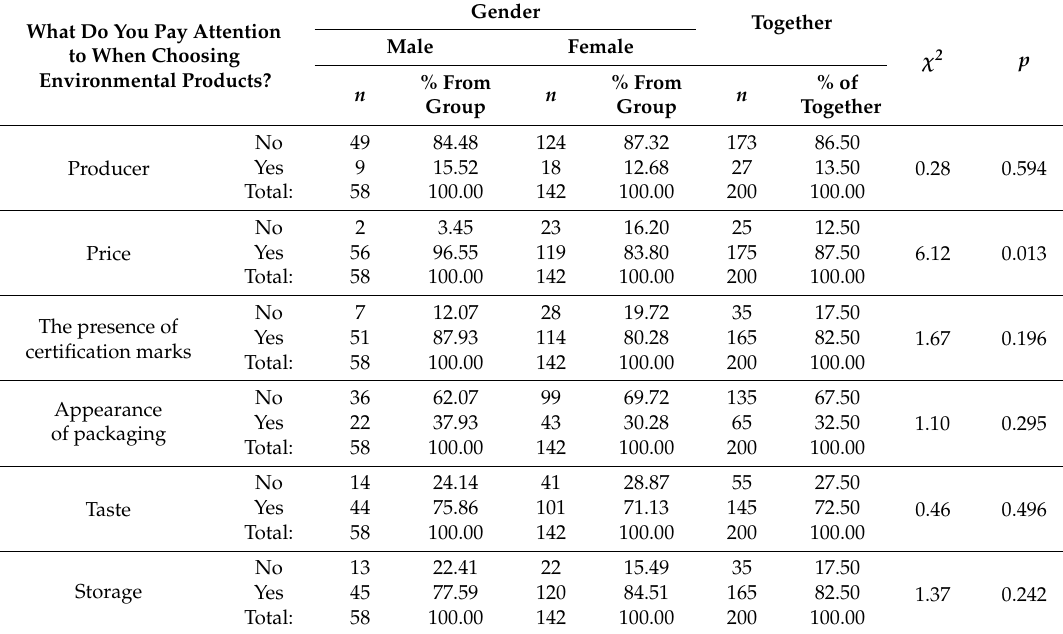
Table 6. Gender vs. the specification of factors most important in the selection of ecological goods of factors— χ 2 independence